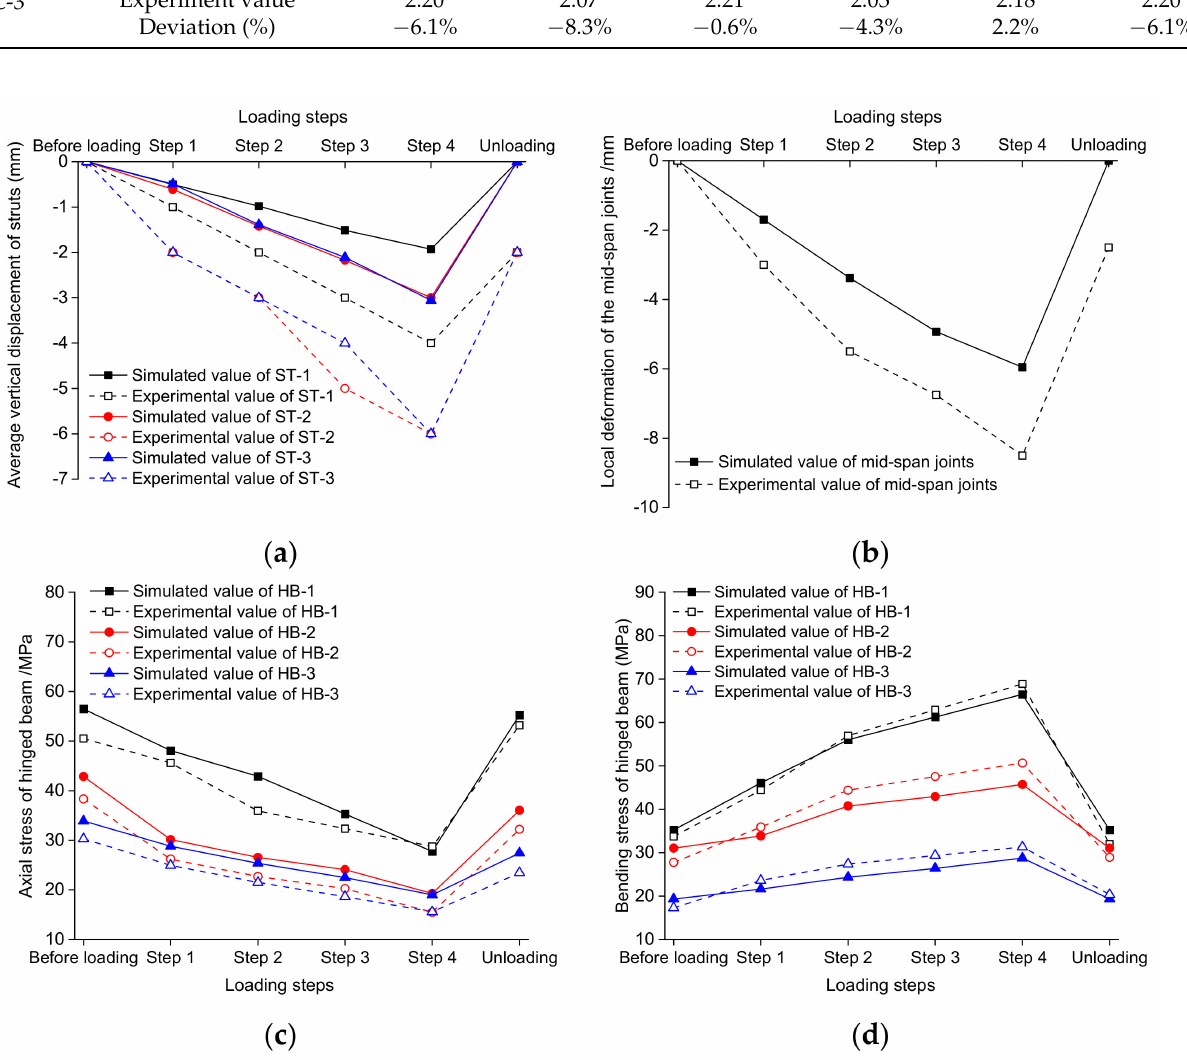
Figure 25. Results of the full-span static loading test. ( a ) Variations of vertical displacement of upper nodes on struts; ( b ) Variations of local deformation of mid-span joints on HBs; ( c ) Axial stresses of hinged beams; ( d ) Bending stresses of